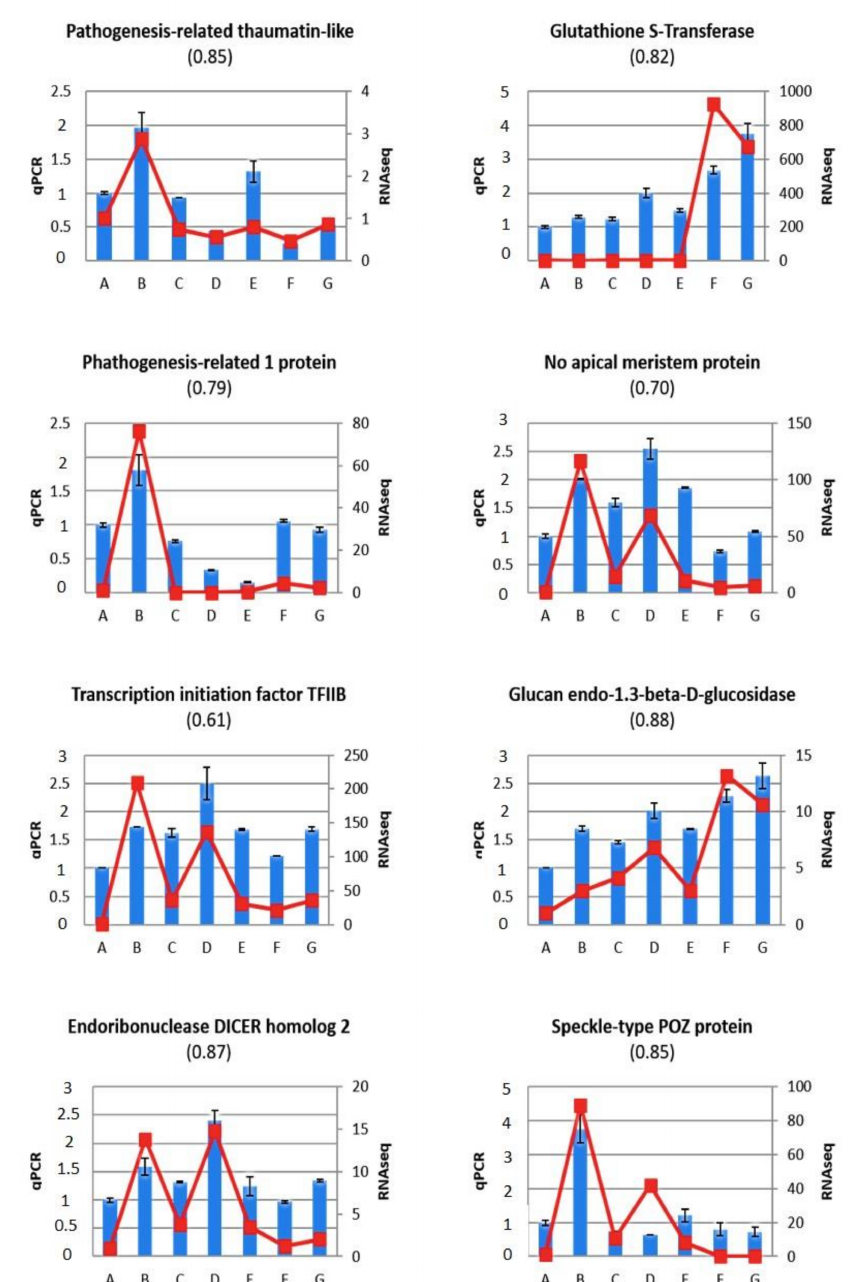
Figure 5. RT-qPCR expression analysis for candidate genes related to the pathogen response selected from the RNA- Seq analysis (blue bars) including: Pathogenesis-related thaumatin-like protein (Prupe.8G163300), glutathione S-transferase (Prupe.1G039900), pathogenesis-related 1 protein (Prupe.1G091400), no apical meristem protein (Prupe.2G204700), transcription initiation factor TFIIB (Prupe.3G255800), glucan endo-1,3-beta-D-glucosidase (Prupe.7G051200), endoribonuclease DICER homolog 2 ( DCL2 ) (Prupe.7G048000) and speckle-type POZ protein (Prupe.1G488200). Relative gene expression (RGE) in the seven samples: control healthy “GF305” peach rootstocks (A); PPV-infected “GF305” rootstocks showing severe sharka symptoms (B); “GF305” peach rootstocks grafted with healthy “Garrigues” (C); PPV-infected “GF305” rootstocks showing sharka symptoms grafted with healthy “Garrigues” (D); healthy “GF305” peach rootstock grafted with healthy “Garrigues” which were later inoculated with PPV at the end of the first cycle of evaluation (E). “Garrigues” almond samples grafted onto healthy (F) and inoculated “GF305” (G) rootstocks. Error bars in qPCR data represent the standard error of three independent biological replicates. Between brackets: Pearson correlation coefficients between FPKM (fragments per kilobase pair of transcript per million mapped reads) values from RNA-Seq (in red lines) and RGE values from